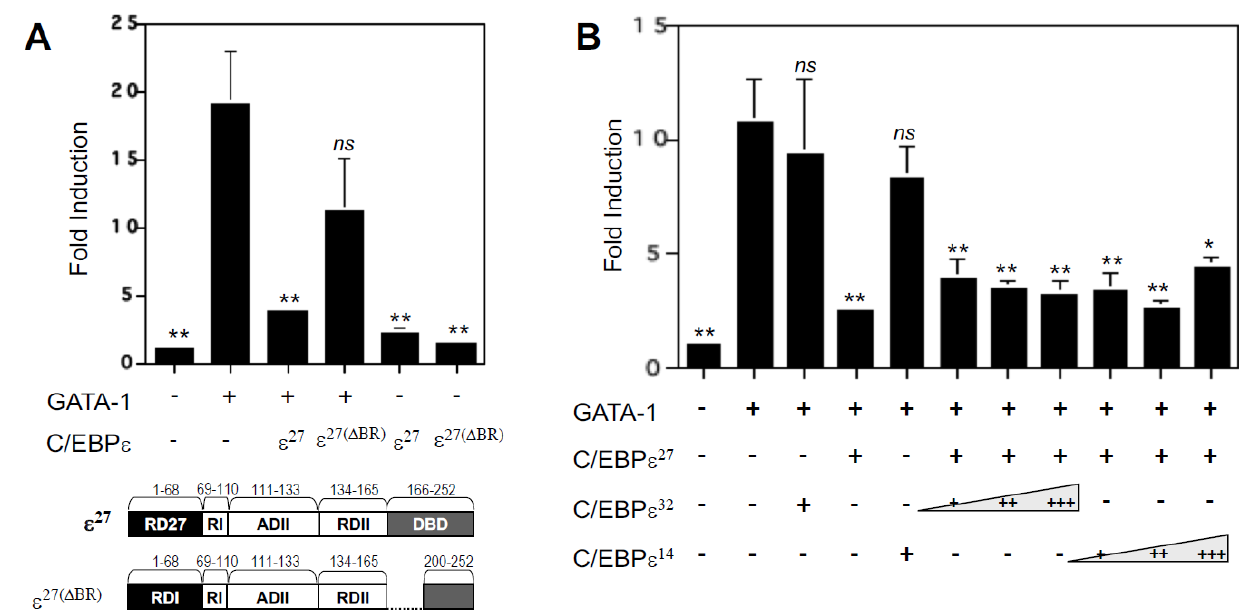
Figure 7. Binding of C/EBP ε 27 to DNA is not required for its repression of GATA-1. ( A ) Structures of wild type C/EBP ε 27 and the C/EBP ε 27 ∆ BR mutant construct (deletion of the basic region of the DNA binding domain, amino acids 166–199) are shown. Fold induction of MBP1-P2 promoter luciferase activity is shown for CV-1 cells co-transfected with GATA-1, C/EBP ε 27 and the C/EBP ε ∆ BR mutant as indicated. Deletion of the basic region of the DNA binding domain of C/EBP ε 27 ( ∆ BR) partially relieves its repression of GATA-1 transactivation of the MBP1-P2 promoter. ( B ) Co-transfection of CV-1 cells with expression vectors for the C/EBP ε 32 and C/EBP ε 14 isoforms does not compete with (block) the ability of C/EBP ε 27 to function as a repressor of GATA-1 transactivation of the MBP1-P2 promoter. * p < 0.05; ** p < 0.01; ns , not significant, compared to GATA-1 alone.